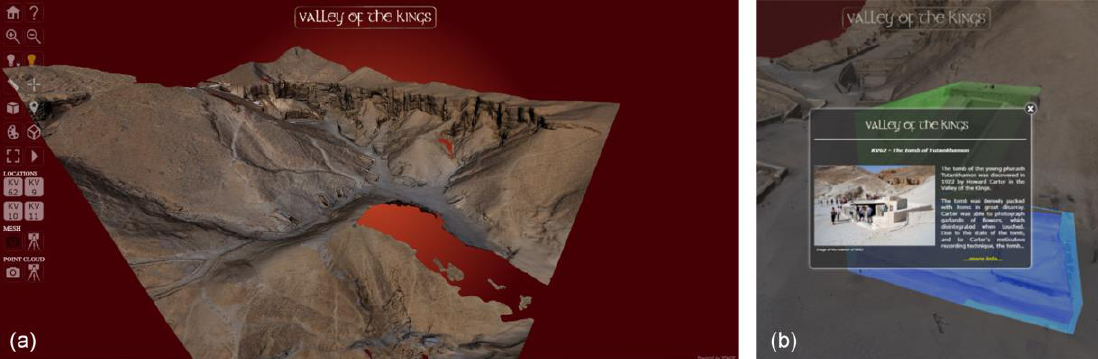
Figure 13. Virtual visit of VOK: ( a ) interactive Web presentations of the high-resolution 3D model; ( b ) hot-Spot function embedded in the 3D viewer.